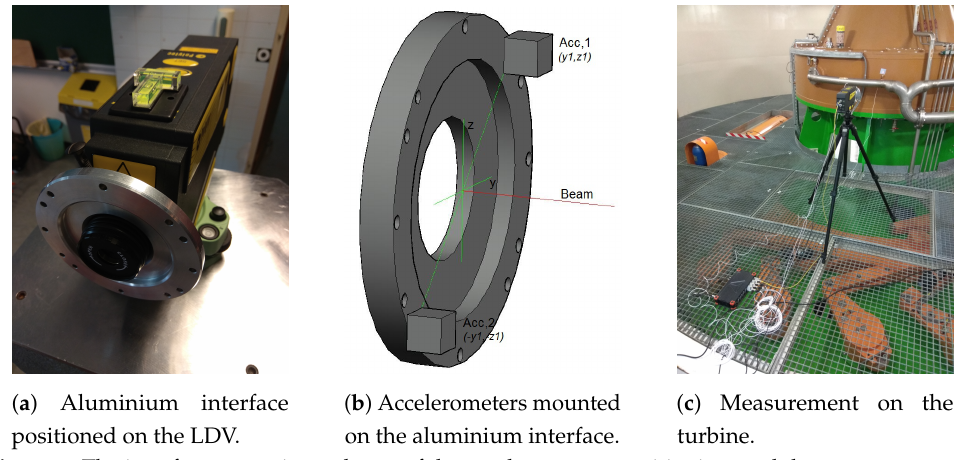
Figure 2. The interface mounting, scheme of the accelerometers positioning, and the measurement on the turbine in Brežice